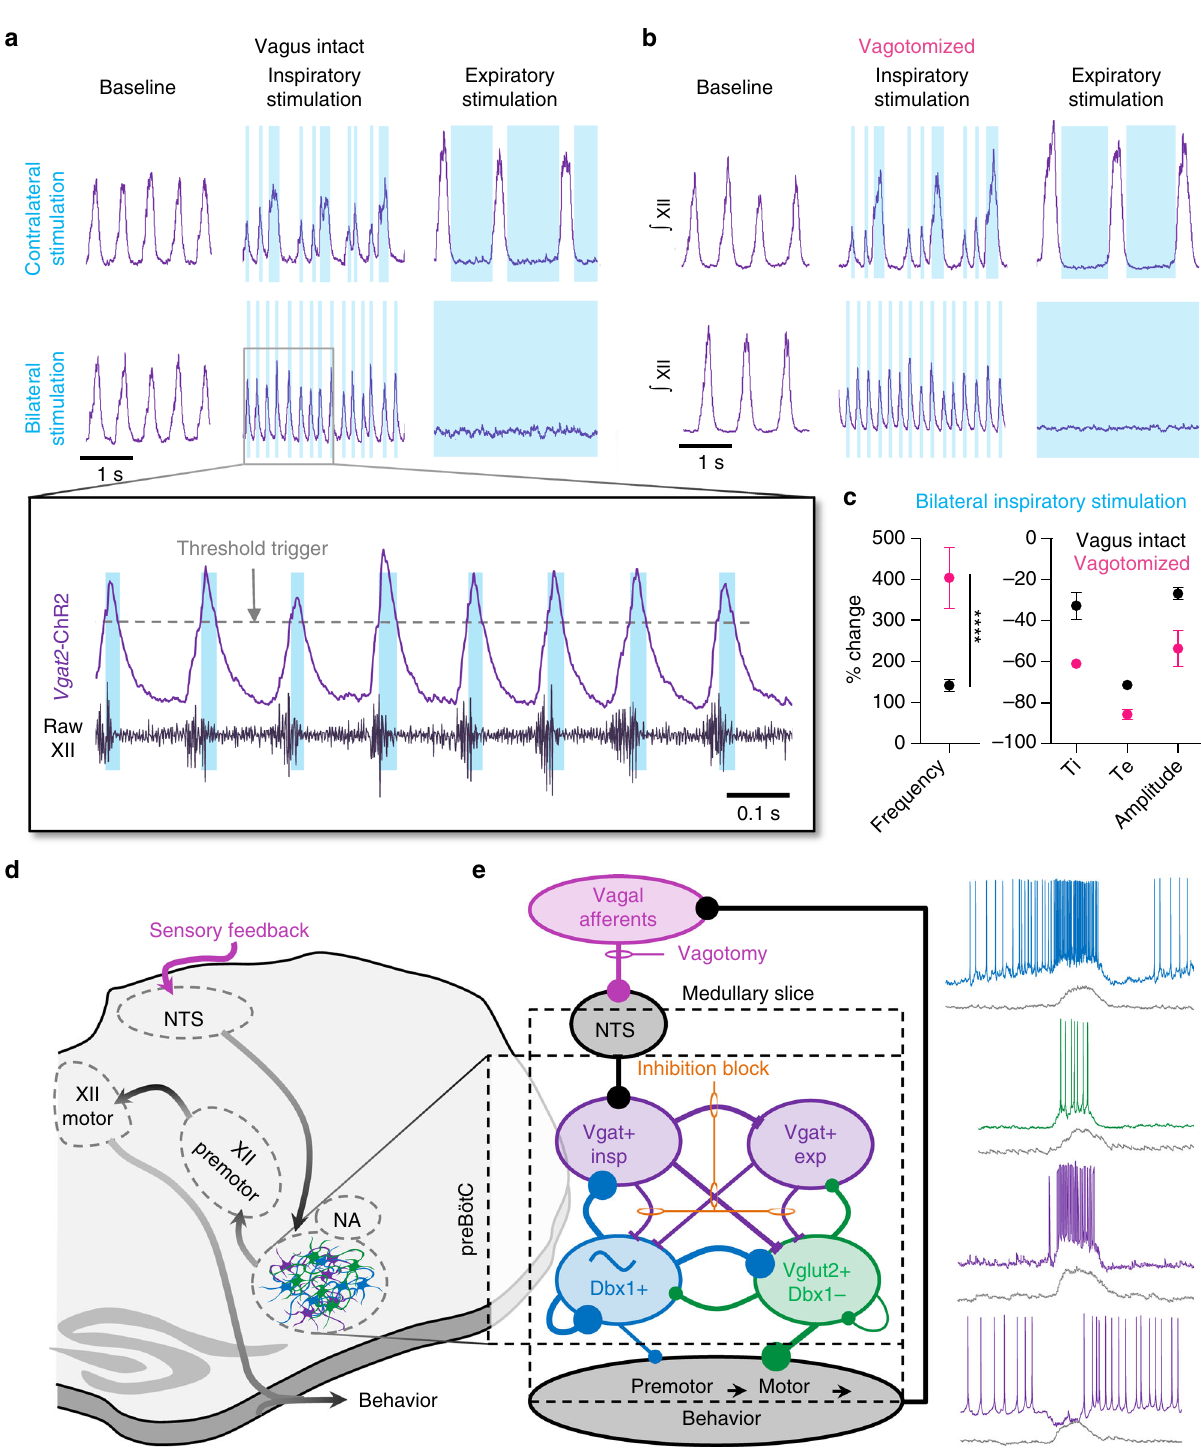
Fig. 10 Rapid breathing is elicited by phasic inhibition during inspiration. a , b Example XII activity at baseline and during unilateral or bilateral light stimulation during the inspiratory or expiratory phase in vagus-intact ( a ) and vagotomized ( b ) Vgat -ChR2 mice. Expanded view demonstrates precise timing of light pulses triggered by the onset of inspiration. Note the irregular rhythm elicited by contralateral stimulation. c Quanti fi ed changes in frequency, Ti, Te, and XII amplitude during bilateral inspiratory light stimulation in vagus-intact ( n = 5; black) and vagotomized ( n = 3; pink) mice (mean ± s.e.m.; two- way ANOVA and Bonferonni ’ s multiple comparisons test; **** p < 0.0001). d , e Model of interactions between excitatory and inhibitory preBötC populations controlling breathing frequency. Representation of the heterogeneous organization of the preBötC and simpli fi ed pathway from sensory input to rhythmogenesis to behavioral output ( d ). Hypothesized interactions between preBötC subpopulations ( e ). Line weight indicates the relative strength of connections. Interactions determine the activity pattern of each neuron type